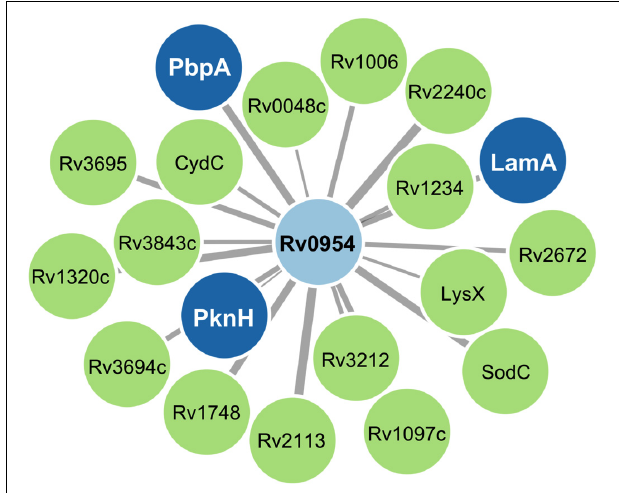
FIGURE 3 | Network map of Rv0954 interacting partners. Cell division-related proteins are marked in blue.